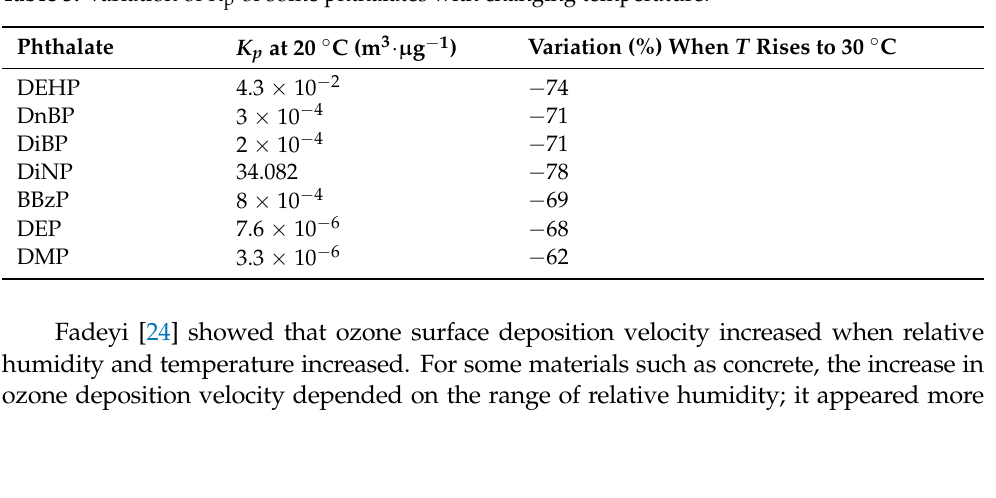
Table 3. Variation of K p of some phthalates with changing